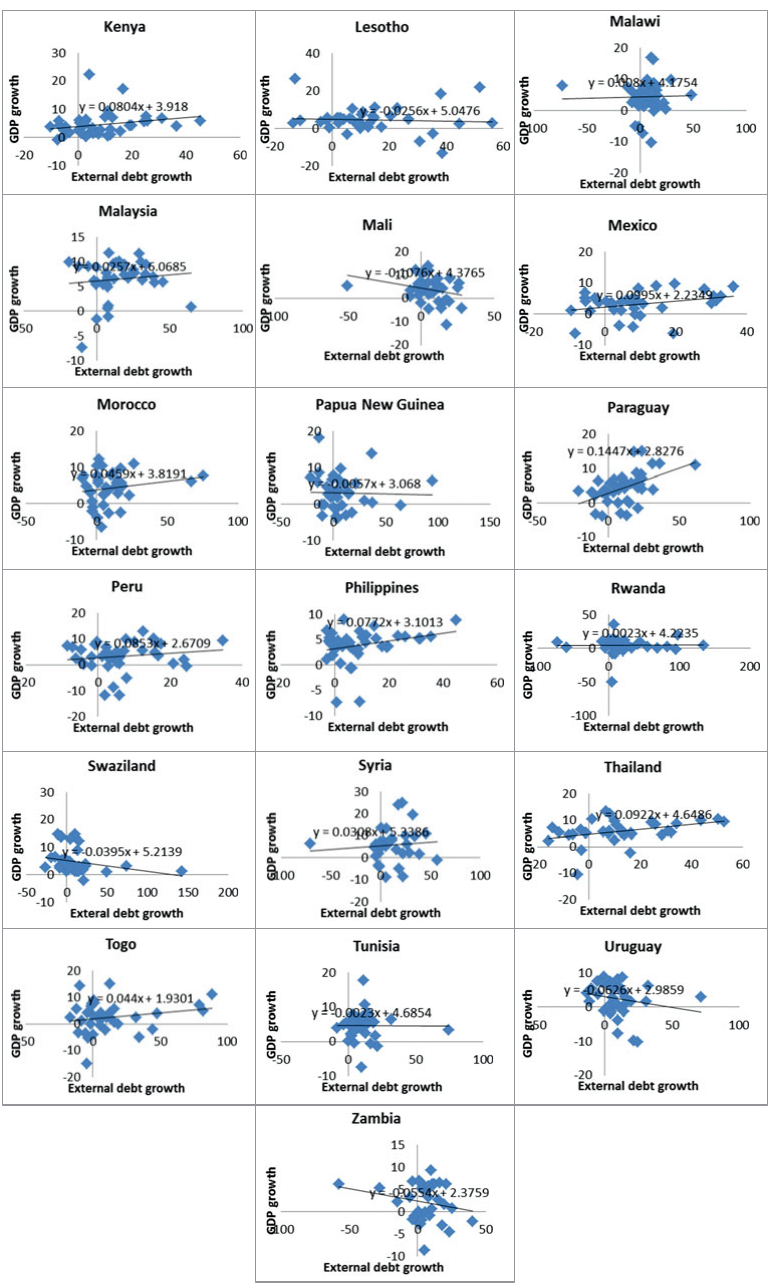
Fig. 1. Country debt-growth nexus